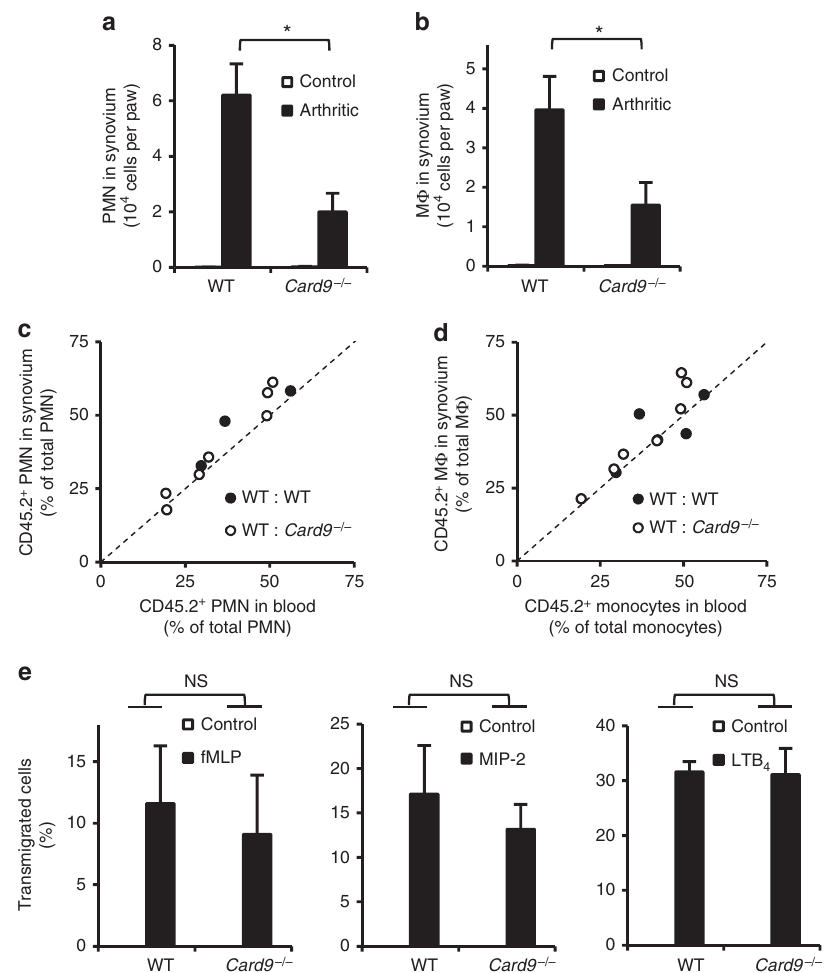
Figure 3 | CARD9 plays no direct role in myeloid cell migration to the site of inflammation. Wild type (WT) and Card9 (cid:2) / (cid:2) mice were subjected to K/B (cid:3) N serum-transfer arthritis ( a – d ), the ankle area or the front paw was flushed on day 4 and the number of neutrophils ( a ) or monocytes/ macrophages ( b ) was determined by flow cytometry. Mixed bone marrow chimeras with CD45.1-expressing wild type (WT) and CD45.2-expressing WTor Card9 (cid:2) / (cid:2) hematopoietic cells were subjected to K/B (cid:3) N serum-transfer arthritis and in vivo accumulation of neutrophils ( c ) and monocytes/ macrophages ( d ) was determined by flushing the synovial area on day 4, followed by flow cytometric analysis of the ratio of CD45.1 and CD45.2- expressing cells in peripheral blood and the synovial infiltrate. In ( c,d ), each dot represents an individual mouse. ( e ) In vitro migration of WTand Card9 (cid:2) / (cid:2) bone marrow neutrophils towards the indicated chemoattractants in a fibrinogen-coated Transwell system. Graphs represent mean and s.e.m. from 5–14 ( a ) or 6–16 ( b ) mice per group from five independent experiments. ( e ) Data represent mean and s.e.m. of three to five independent experiments. * P o 0.05; NS, statistically not significant (Student’s t -test ( a , b ), two-way ANOVA ( e )); see the text for actual P